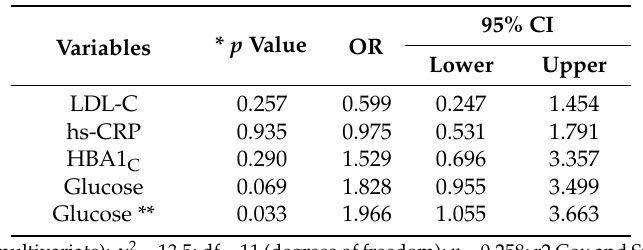
3. Pearson’s correlation coefficients in normo-/hyperglycemic and normo-/hypercholesterolemic state.